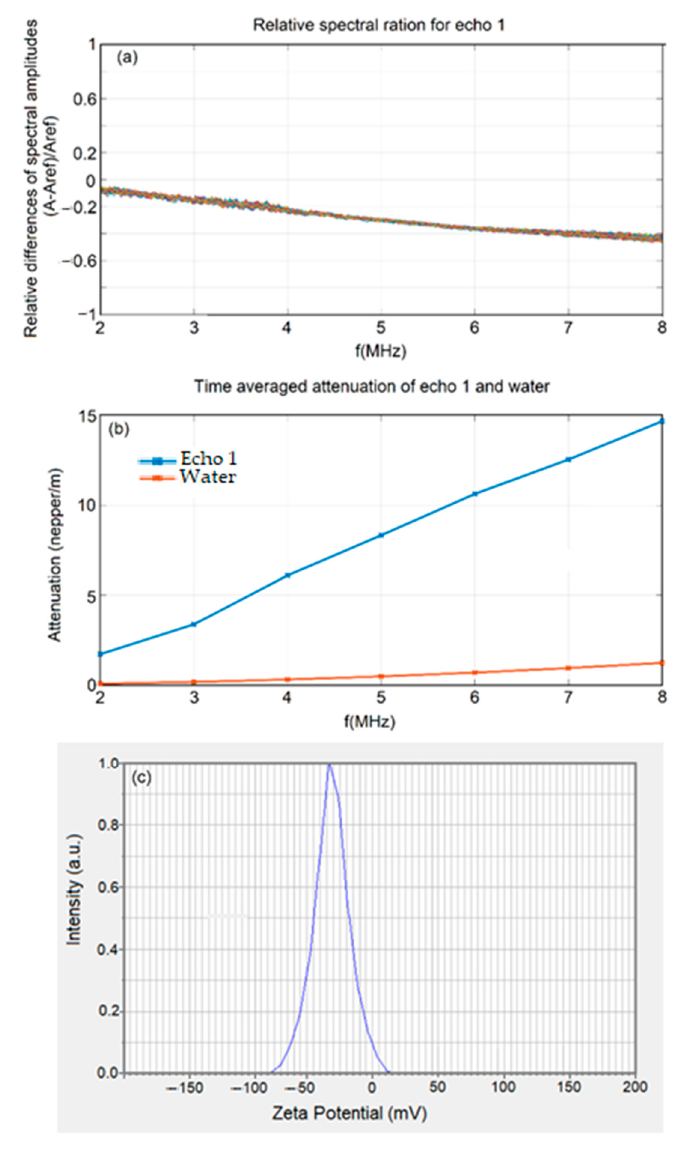
Figure 1. Relative spectral amplitude as a function of frequency ( a ), attenuation as a function of frequency ( b ), and zeta potential ( ξ ) of 5EuHAp suspension ( c ). frequency ( b ), and zeta potential ( ξ ) of 5EuHAp suspension ( c